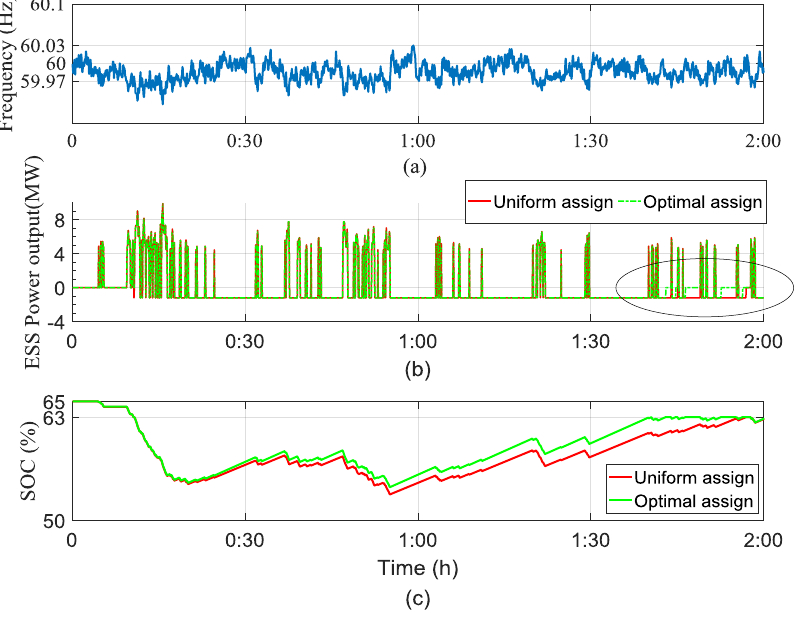
Figure 14. Effect of loss on the frequency regulation operation: ( a ) Frequency; ( b ) ESS power output, and; ( c ) SOC.